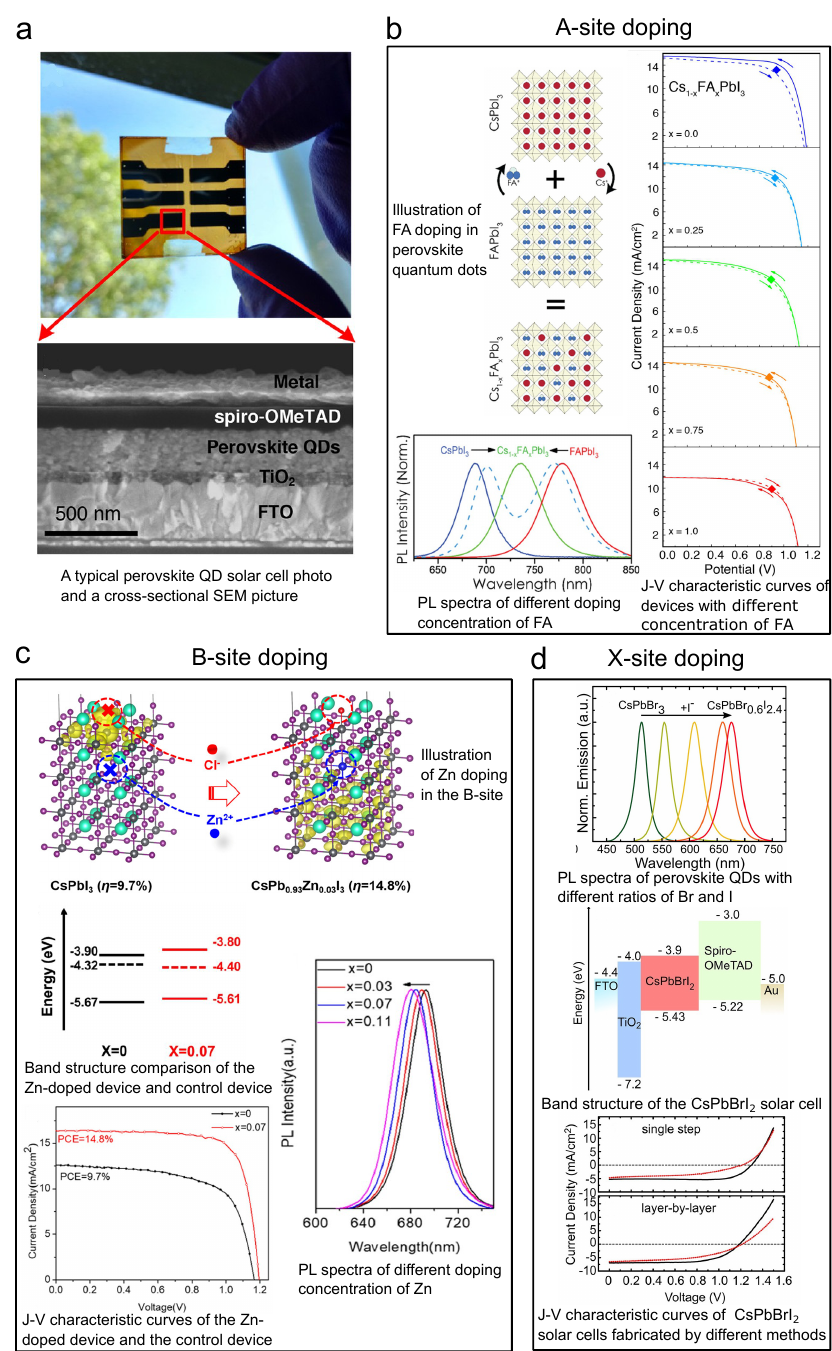
Figure 11. Key graphs of iconic perovskite CQD solar cells accomplished by A-, B-, and X-site doping. Explanation of each sub-figure is shown beside it. ( a ) Typical device picture and SEM cross-sectional structure. ( b ) FA-doped (A-site) perovskite solar cell. Reprinted with